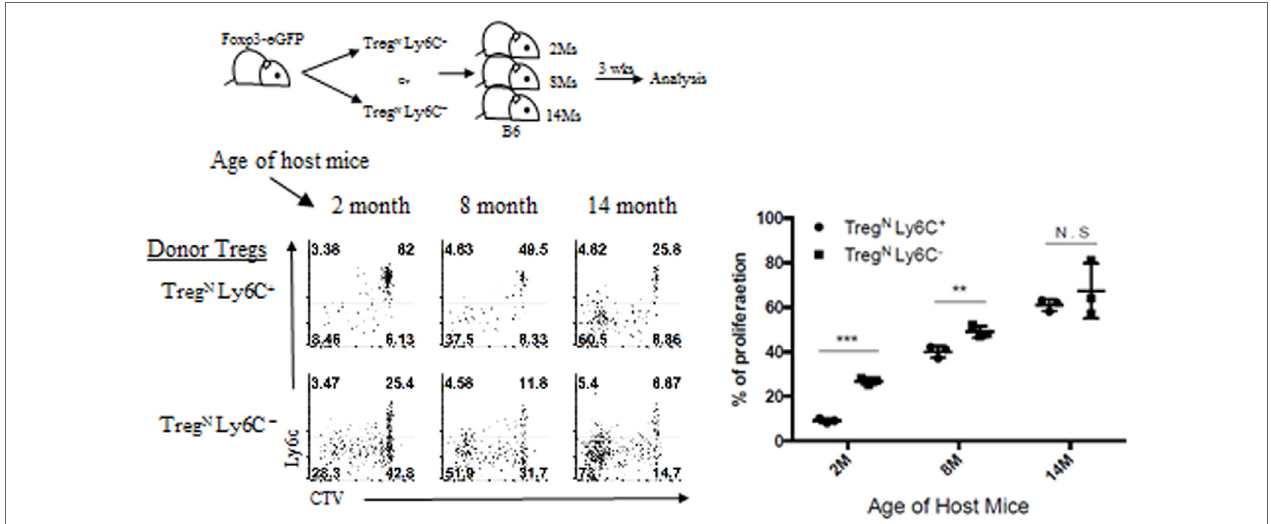
FigUre 5 | Age-dependent conversion of Treg N Ly6C + subset into Treg Eff . T regulatory (Treg) subsets from Thy1.1 + Foxp3-eGFP were labeled with cell tracker violet and then injected into differentially aged hosts. Donor cell proliferation was analyzed 3 weeks after transfer. The data are representative of three experiments comprising three to five mice per group. * p < 0.05, ** p < 0.01, and *** p <